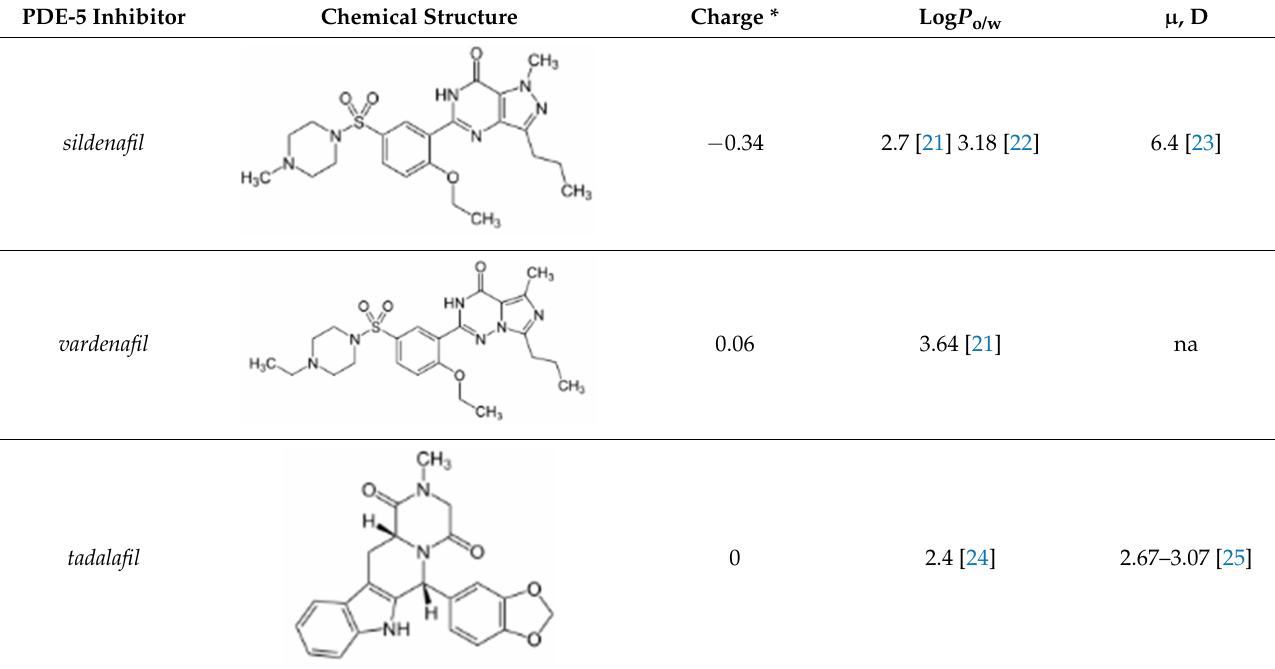
Table 1. The physicochemical properties of the tested PDE-5 inhibitors: electrical charge (charge), the logarithm of octanol/water partition coefficient (Log P o/w ), and dipole moment ( µ